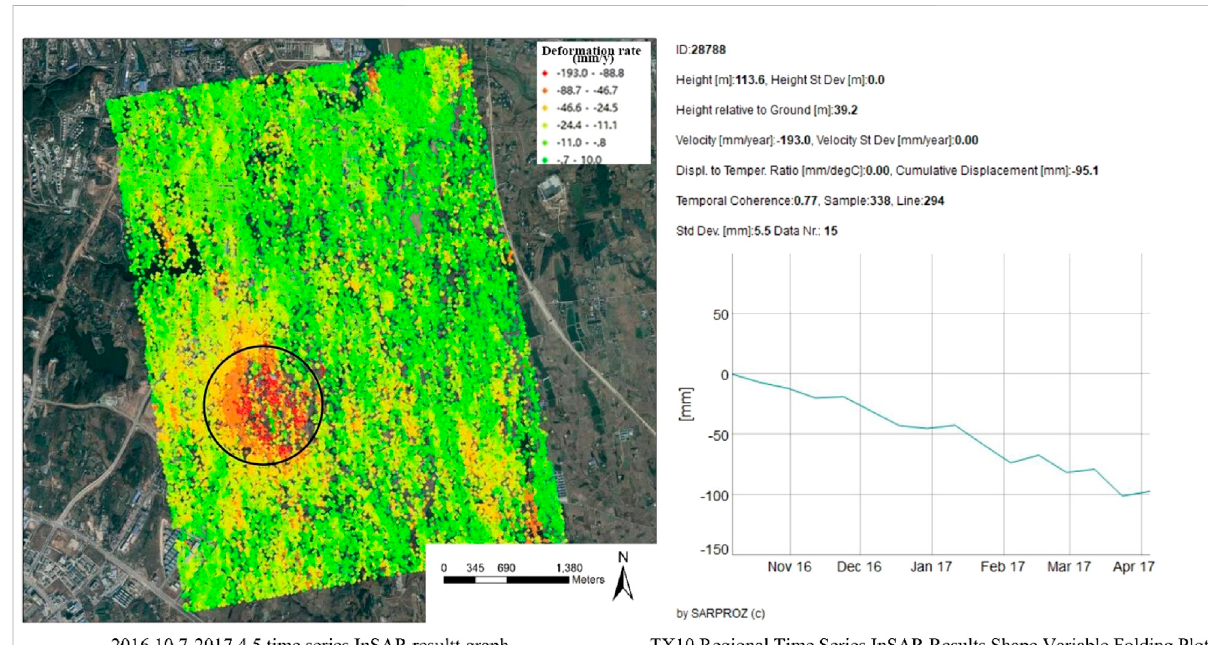
FIGURE 11 TX10 regional time series InSAR results and line graphs of shape